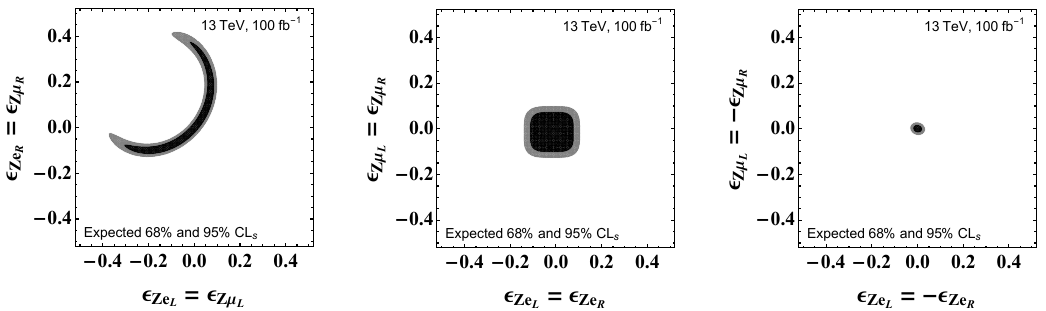
p s = 13 TeV) for scenarios 4, 5,